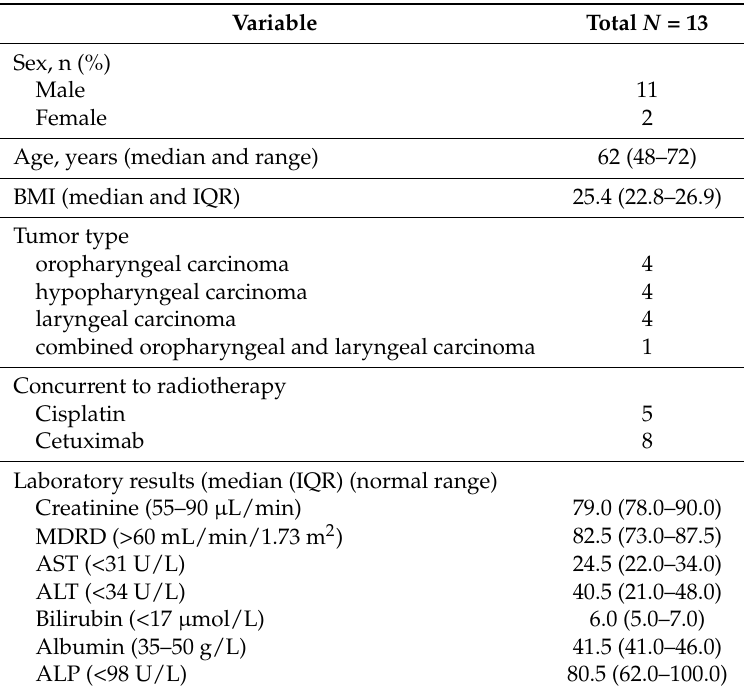
Table 1. Patient characteristics.